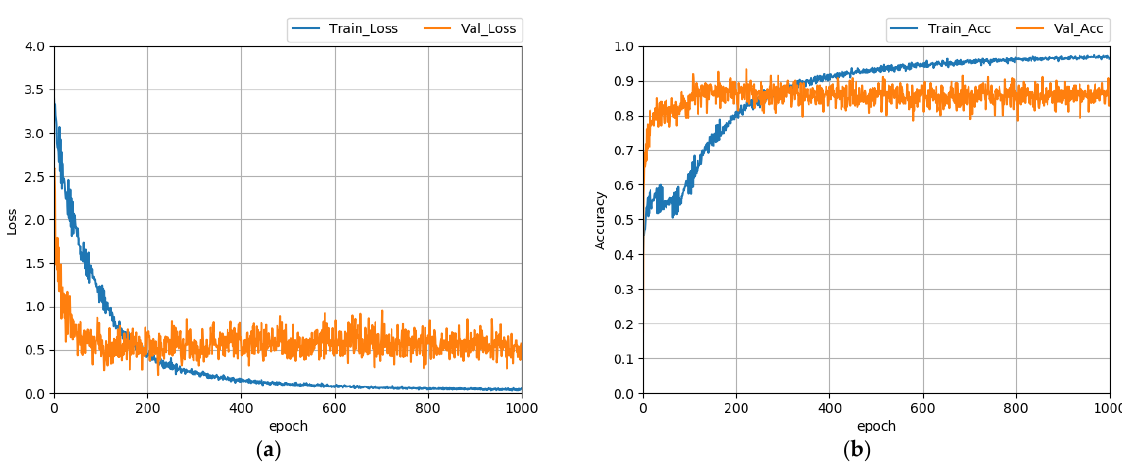
Figure A2. Training result for the triplet loss learning method. ( a ) loss; ( b ) accuracy. In addition, the ArcFace model was trained using the ArcFace learning method with 1000 epochs. Figure A3 illustrates the training results.